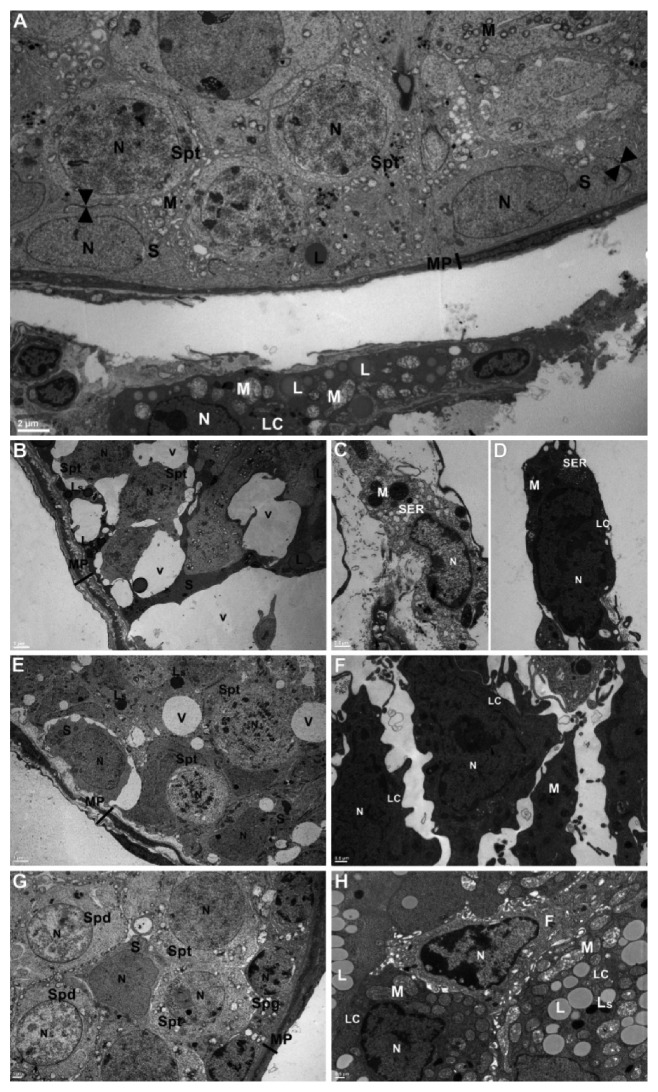
Electron microscopic view of testicular tissue samples of EDS-administered subjects (Group 2). (a) Membrane propria (MP), Sertoli cells (S), spermatocytes (Spt), and spermatids (Spd) were in normal structure in control subjects of Group 2 (Group 2A). Tight connections between the Sertoli cells (arrowhead) were seen in normal structure. Tubular-type mitochondria (M) and abundant lipid droplets (L) were observed in the cytoplasm of Leydig cells (LC). N: nucleus; bar = 2 μm. (b) An increase in membrane propria (MP) total thickness and giant vacuoles (V) between Sertoli cells (S) and spermatocytes (Spt) was observed in GnRH-antagonist-administered subjects of Group 2 (Group 2B). Ls: lysosome; bar = 2 μm. (c) Low electron density and agranular endoplasmic reticulum (SER) vacuolization were seen in some Leydig cells (LC) in testicular tissue samples of Group 2B. Mitochondria (M) were intact. Bar = 0.5 μm. (d) In some Leydig cells, a decrease in the cytoplasmic volume and an increase in peripheral heterochromatin patches in the nucleus (N) were also observed in testicular tissue samples of Group 2B. Bar = 0.5 μm. (e) Thickening and irregularity in the membrane propria (MP) were seen to continue. A relative decrease in the volume of the vacuoles between Sertoli cells (S) and spermatocytes (Spt) was observed in GnRH-antagonist-and-osteocalcin-administered subjects of Group 2 (Group 2C). Bar = 2 μm. (f) A decrease in the cytoplasmic volumes of Leydig cells (LC) and a decrease in the amount of indentation in the nucleus (N) and in the content of heterochromatin were observed in testicular tissue samples of Group 2C. Bar = 0.5 μm. (g) Sertoli cells (S), spermatogonia (Spg), and spermatocytes (Spt) surrounded by membrane propria (MP) were seen to be normal in only-osteocalcin-administered subjects of Group 2 (Group 2D). Bar = 1 μm. (h) Numerous lipid droplets (L) were observed in the cytoplasm of Leydig cells (LC) containing the nucleus (N) in normal structure in testicular tissue samples of Group 2D. F: fibroblast; bar = 0.5 µm.